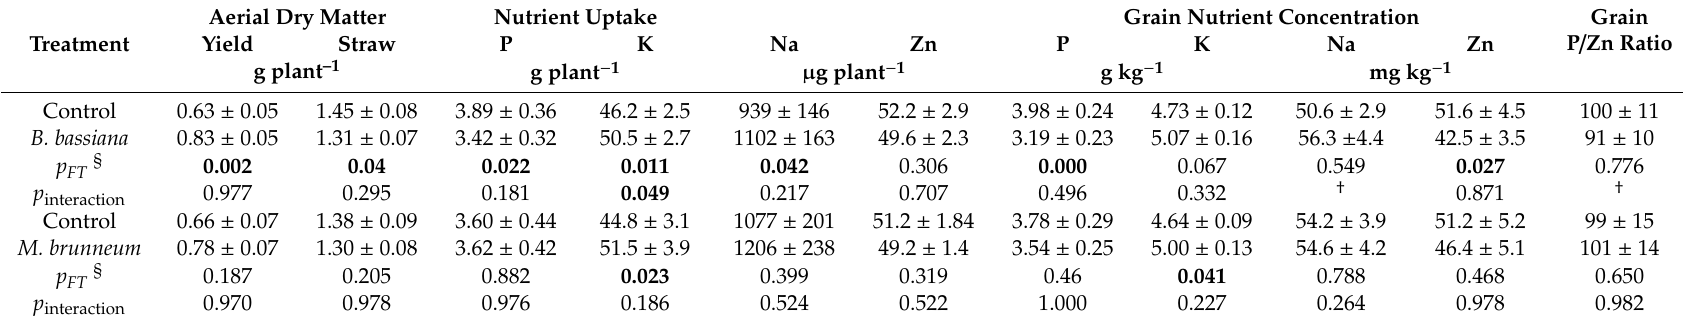
Table 3. Factorial ANOVAs for biomass, nutrient uptake and grain nutrient (P, K, Na, Zn) concentration (mean ± standard error, n = 6), with soil and fungal treatment as factors, for GSGYI > 15. ‡